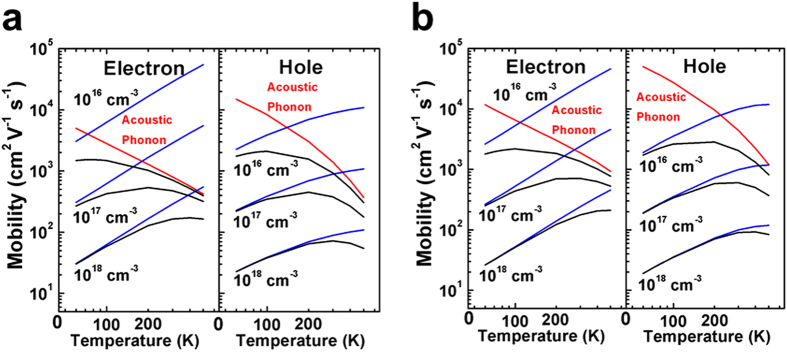
Temperature dependence of the charge carrier mobility limited by acoustic phonon and charged impurity scatterings.(a) Cubic CH3NH3PbI3 in the [100] direction. (b) Tetragonal CH3NH3PbI3 in the [001] direction. The free carrier density was taken as 1014 cm−3 for both electrons and holes, and the charged impurity density was set to 1016, 1017, and 1018 cm−3 respectively. The total mobility is shown in black, and that limited by acoustic phonon and charged impurity scatterings is shown in red and blue respectively.